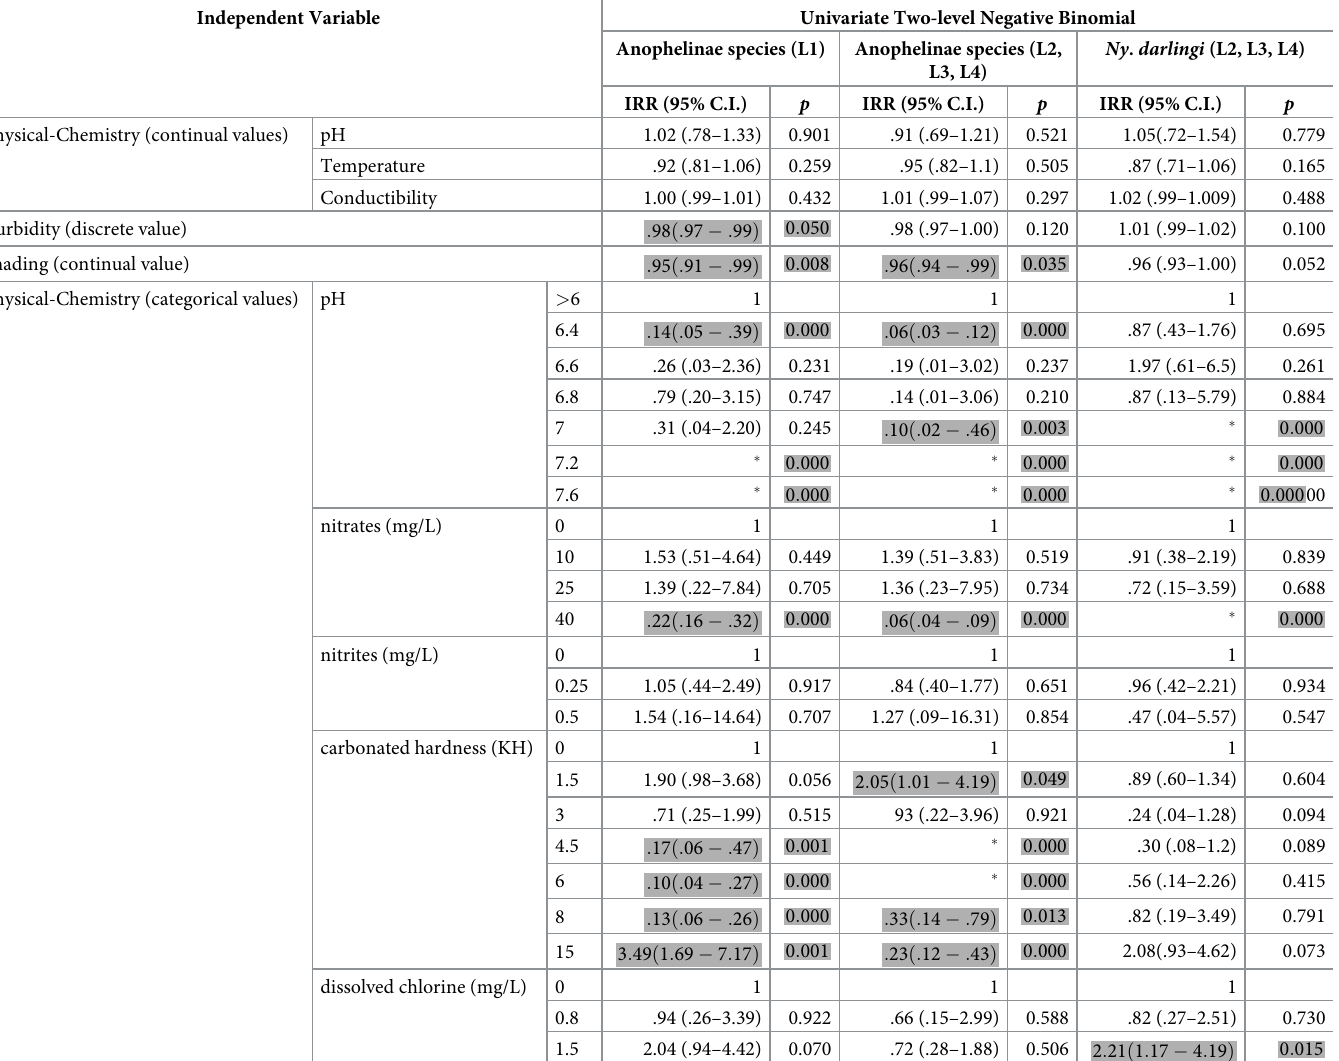
Table 3. Incidence Rate Ratio (IRR), 95% Confidence Interval and p values for Anophelinae species identity-group, for three-month survey univariate two level neg- ative binomial regression. Independent Variable Univariate Two-level Negative